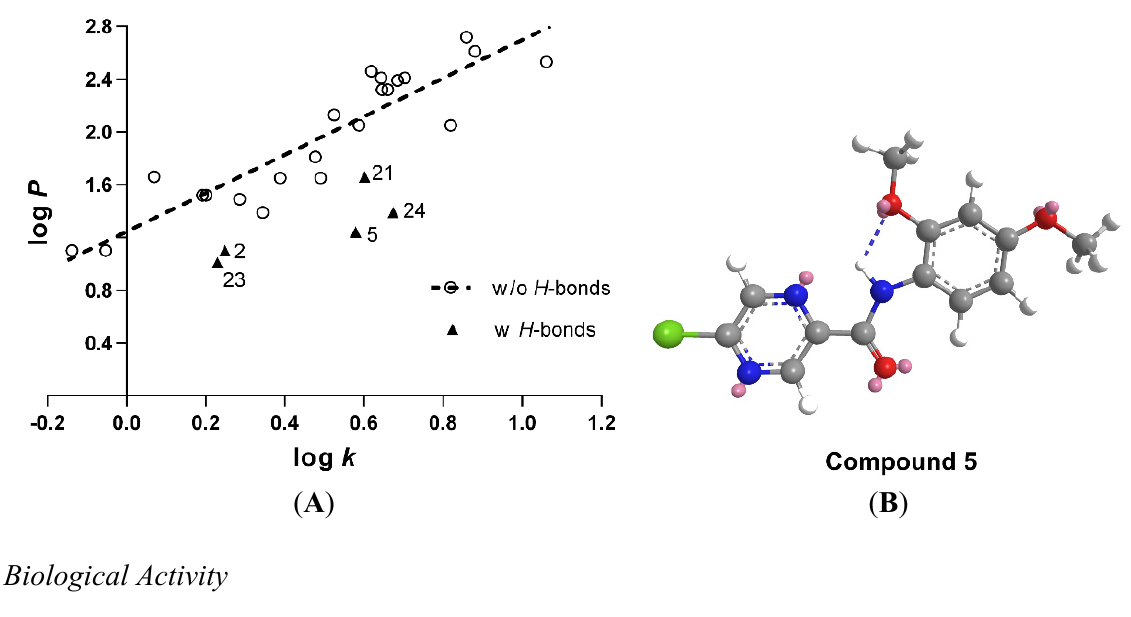
Figure 1. ( A ) Correlation of predicted lipophilicity parameter log P and experimentally determined log k. Linear regression parameters: R 2 = 0.823, s = 0.2142, F = 93.03, n = 22. Compounds capable of H- bonds formation by their ortho substituents on the phenyl ring are indicated by triangle marks and were omitted from regression analysis. ( B ) Model of compound 5 including the intramolecular H-